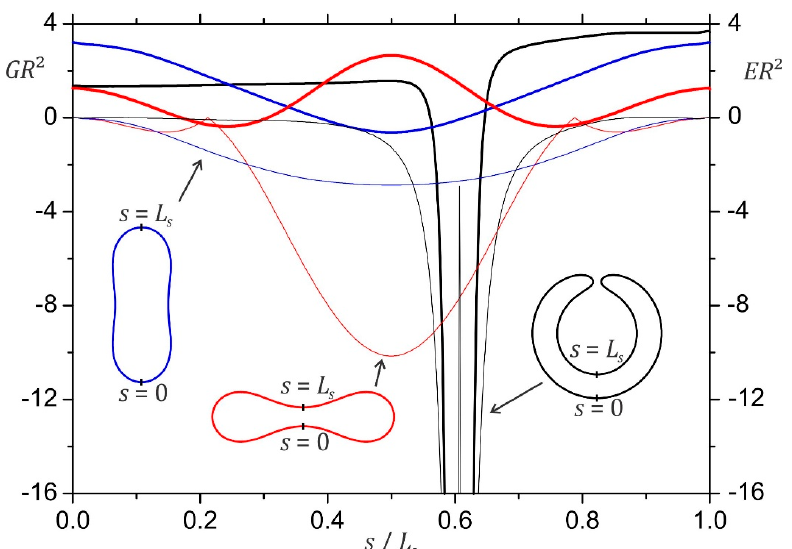
Figure 1. Typical 𝐺(𝑠) (thick lines) and 𝐸(𝑠) (thin lines) spatial variations for stomatocytes (black color), oblates (red color) and prolates (blue color). 𝐿 (cid:3046) is the length of the profile curve and 𝑅 the color), oblates (red color) and prolates (blue color). L s is the length of the profile curve and R the radius of the sphere with the same surface area as the surface of the investigated shape.